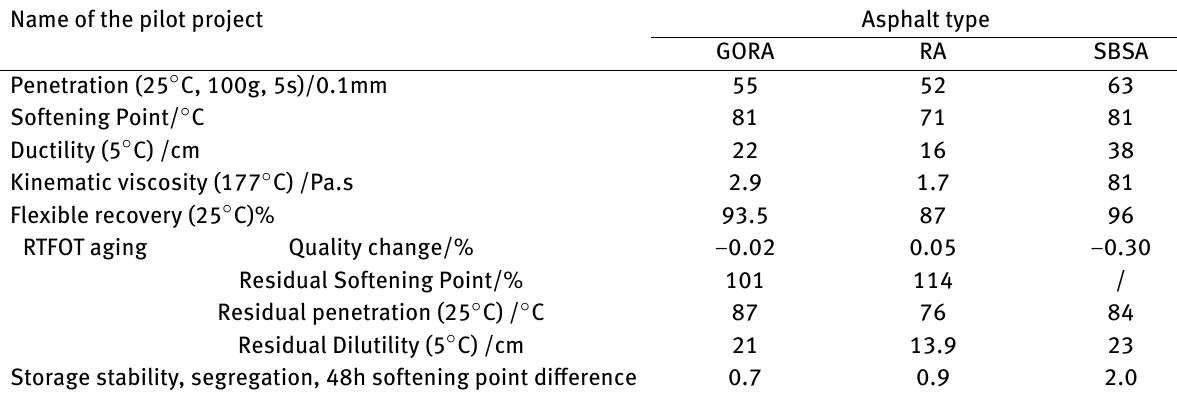
Table 3: Technical indicators of asphalt samples Name of the pilot